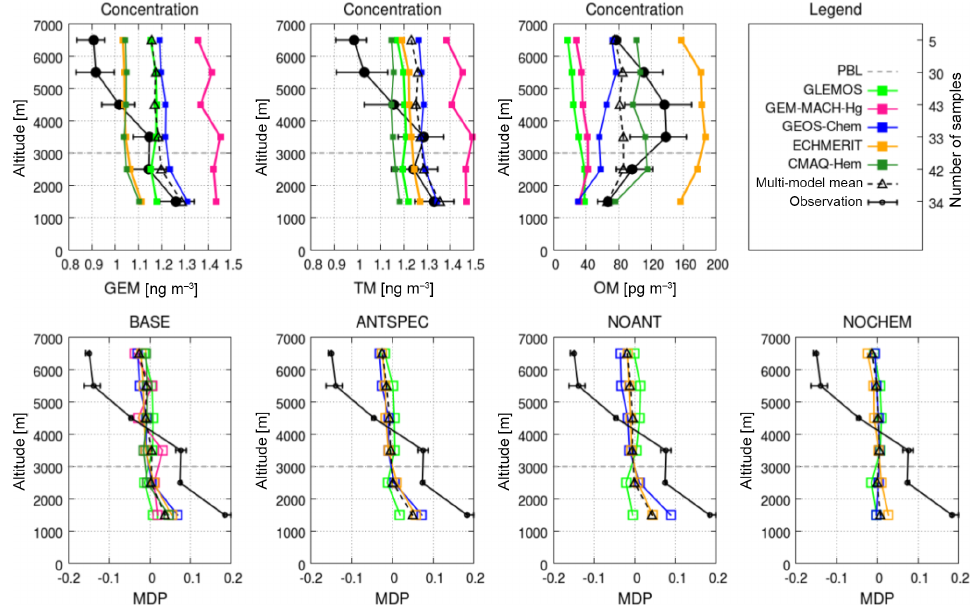
Figure 6. Comparison of modelled average mercury profile for North America to observations based on vertical profiles at Tullahoma, TN, from April to June 2013 (Brooks et al., 2014). The error bars indicate the 66% quantile range of the observations in each altitude; the sample size for each altitude is indicated on the y axis of the legend. The mean deviation profiles (MDP) are given for